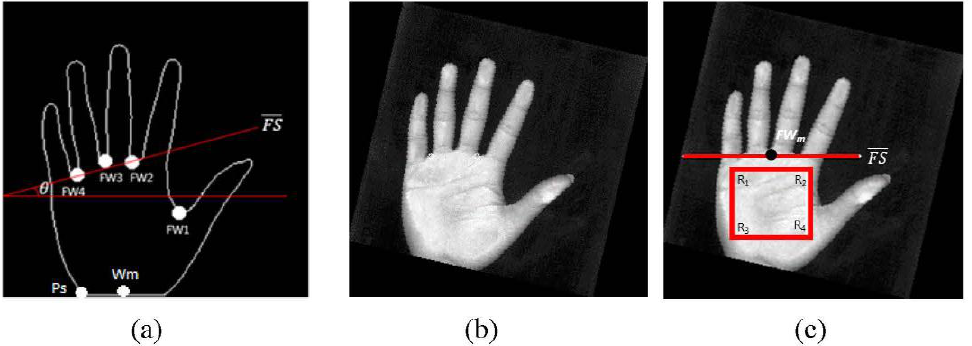
Figure 5. ( a ) Locations of the four finger webs FW 1 , FW 2 , FW 3 , and FW 4 . Line FS is formed by FW 2 and FW 4. The angle θ is measured between line FS and a horizontal line; ( b ) The resulting image rotated with angle θ ; ( c ) Location of the ROI.